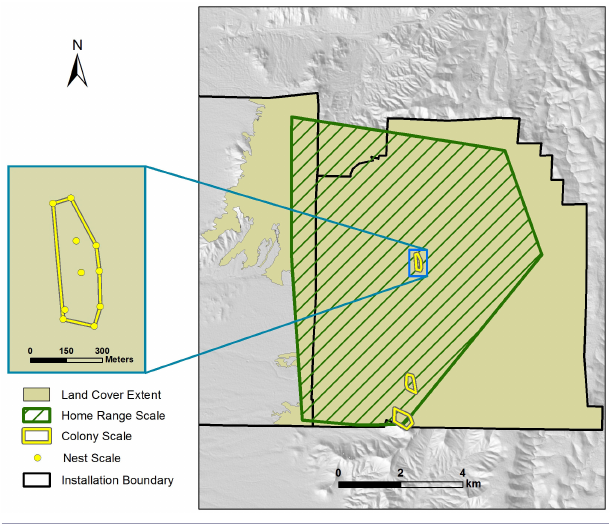
Fig. 1 . Scales of Pinyon Jay ( Gymnorhinus cyanocephalus ) habitat use. Home ranges (landscape scale) cover thousands of hectares. Nesting colonies (ecosystem scale) within home ranges cover tens of hectares; multiple nesting colonies can occur within one flock home range. Within nesting colonies, individual nest sites (not addressed in this paper) are smaller than one hectare; multiple nests occur within a nesting colony. Land cover data (background) over each study site were used to create both home range- and colony-scale